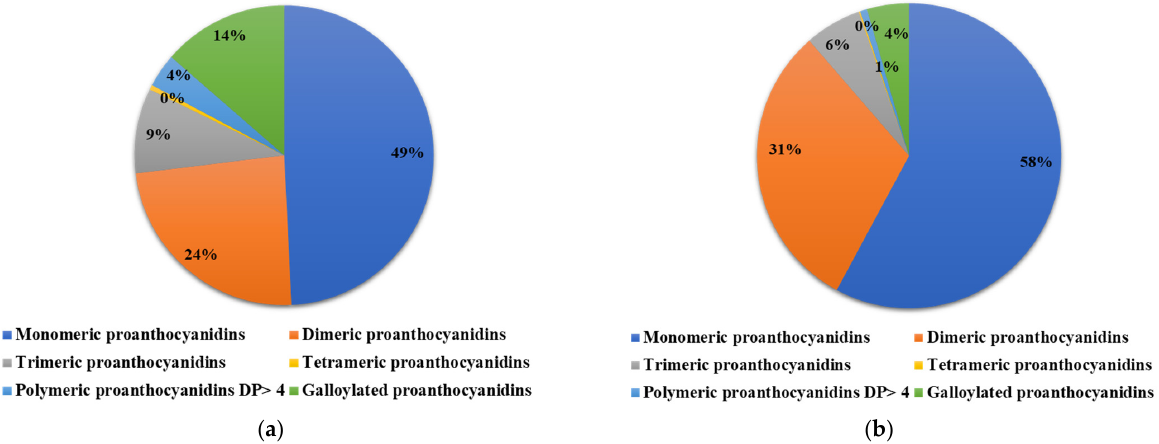
Figure 2. Percentage composition (area%) of proanthocyanidins (PACs) identified in ( a ) GSE sample and ( b ) ATGSE sample by UHPLC ‐ ESI HRMS/MS analysis.